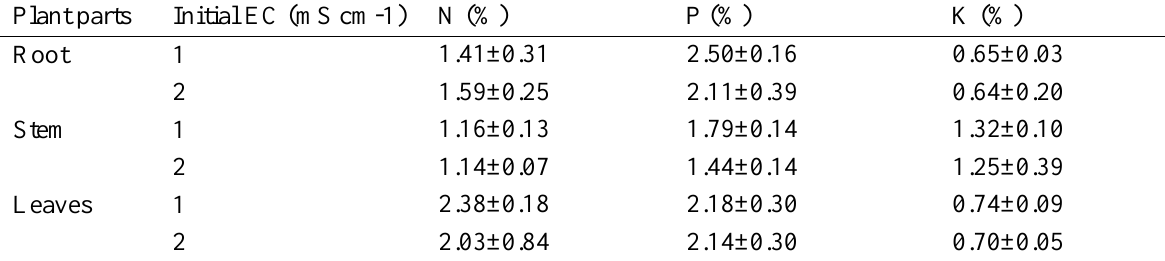
Table 2. Macronutrient contents in different solution